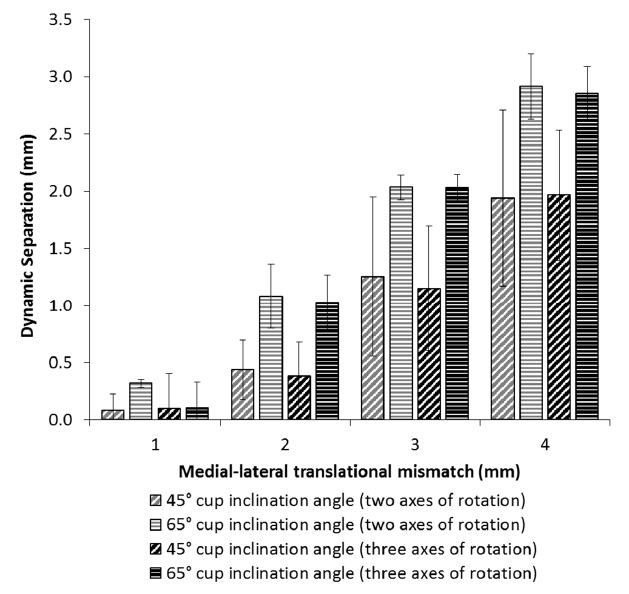
Figure 4. Dynamic separation (mean ± 95% confidence limits, n = 3) of 36 mm diameter BIOLOX ® delta ceramic-on-ceramic bearings under two axes and three axes of rotation conditions with 45° and 65° cup inclination angle conditions and 1, 2, 3 and 4 mm of medial-lateral translational mismatch